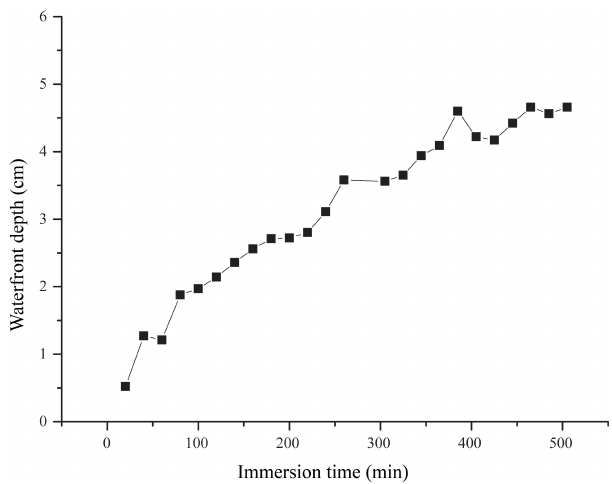
Figure 2. Waterfront depth advance in